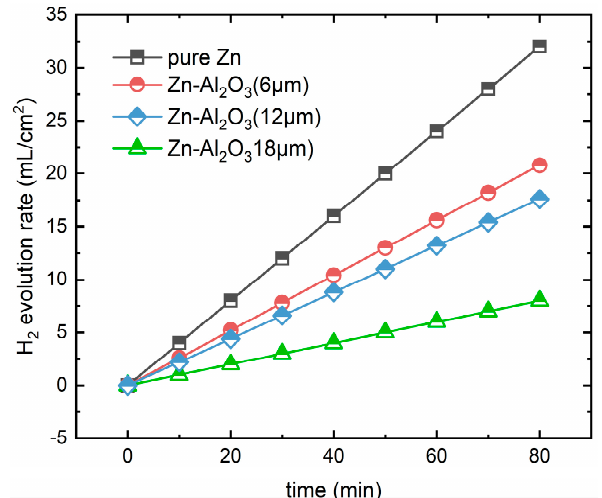
Figure 4. Hydrogen evolution rates of the bare and different thicknesses of Al 2 O 3 -coated zinc substrates in 4 M KOH solutions.